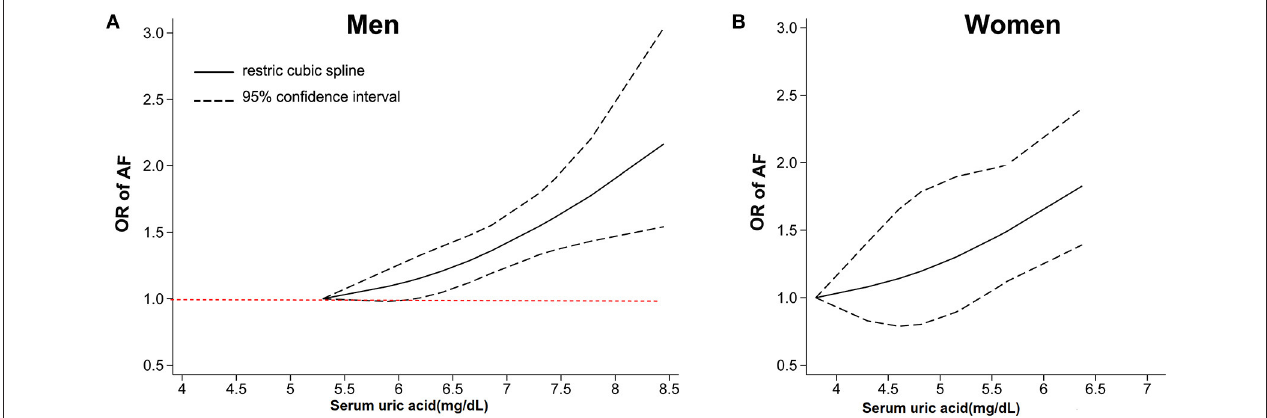
FIGURE 4 | Dose-response analysis between serum uric acid levels and the risk of AF among men (A) and women (B) . The dose-response association was fitted by the restricted cubic splines model, and the solid and dashed lines represent the estimated odds ratio and the 95% confidence interval, respectively. AF, atrial fibrillation OR, odds